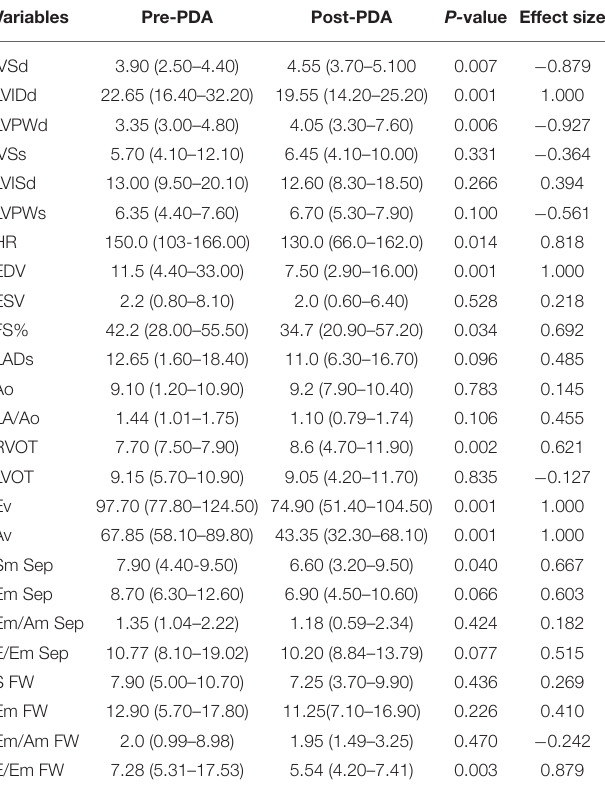
TABLE 1 | Echocardiographic measurements in dogs before and after PDA